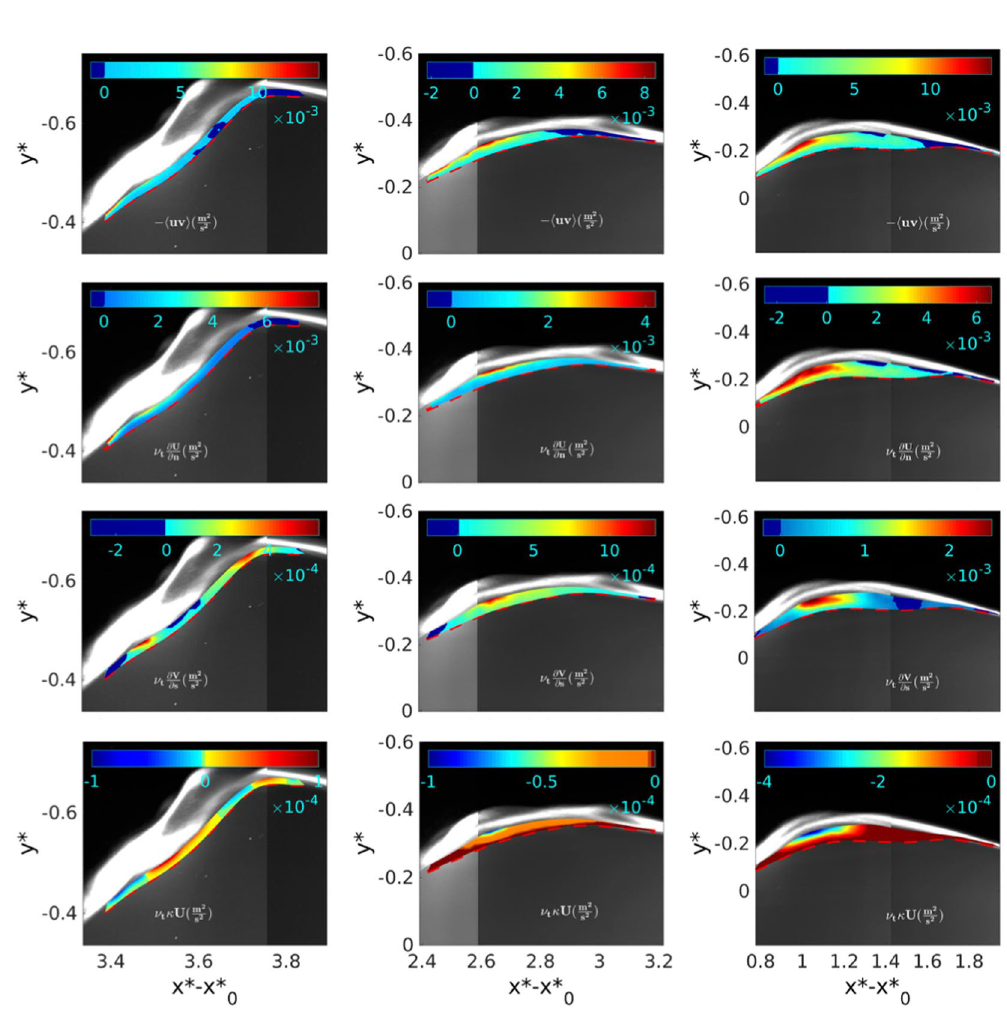
Figure 2. From left to right and from top to bottom, spatial maps, at ⁎ t (right column), of the Reynolds stress ( − 〈 uv 〉 ), mean simple shear ( ν t ∂ U / ∂ n ), streamline curvature ( ν t ∂ V / ∂ s ) and geometric curvature ( ν t κ U ), respectively. The dashed red line gives the lower boundary ϒ of the turbulent